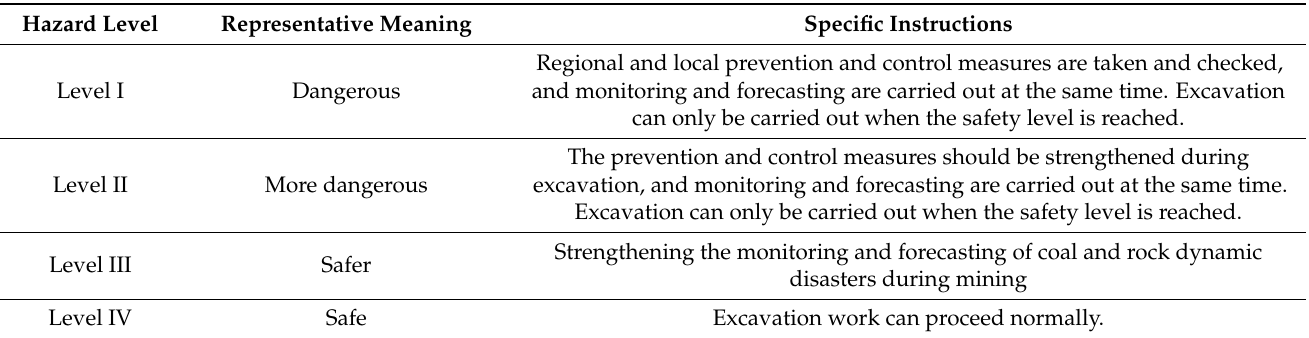
Table 2. Meaning and statement of hazard